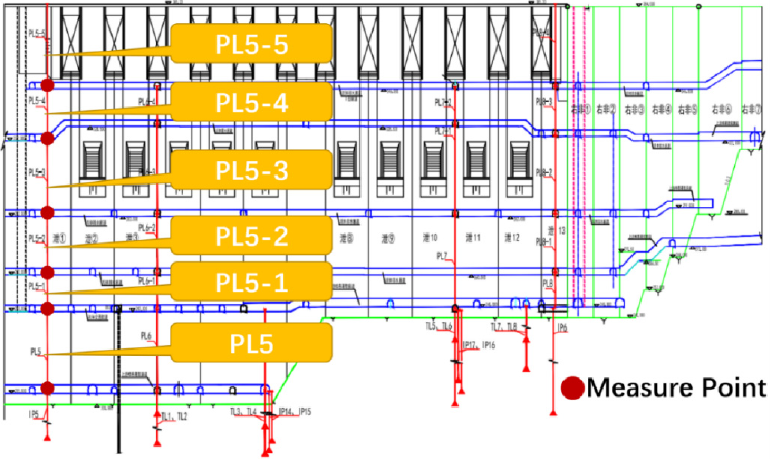
Figure 6. Arrangement of measuring points on inverted vertical line of dam sluice section.